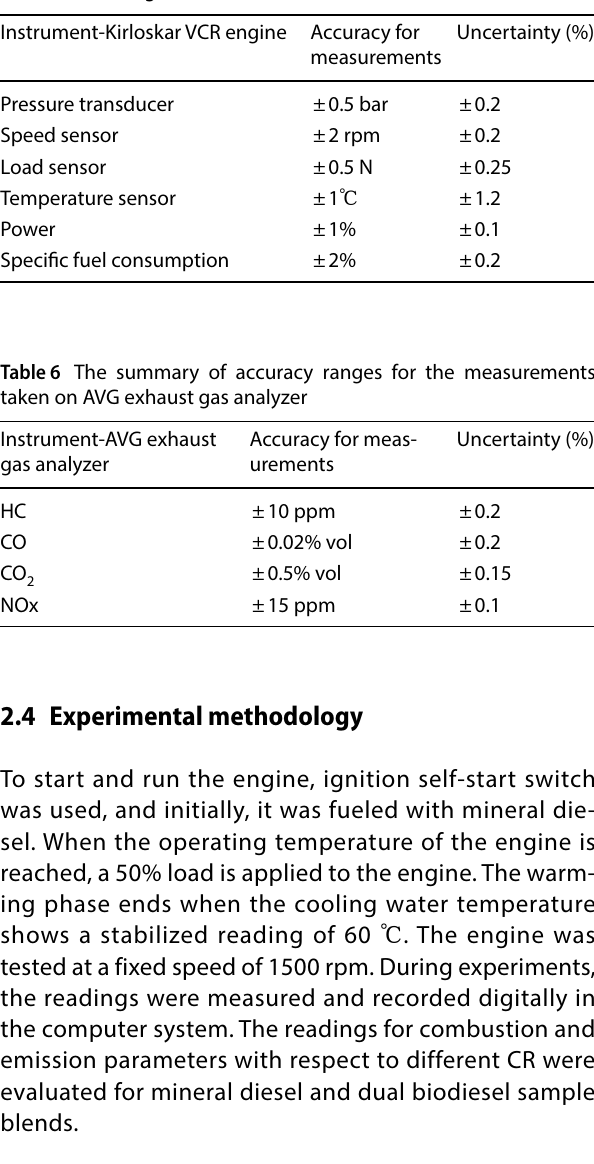
Uncertainty (%) measurements